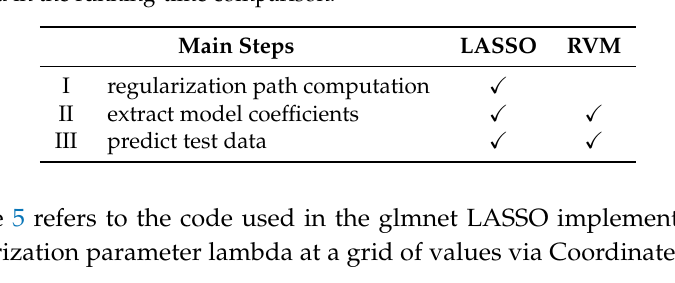
Table 5. Main steps of the implementations of the two procedures at hand in this paper. Such steps are directly involved in the running-time